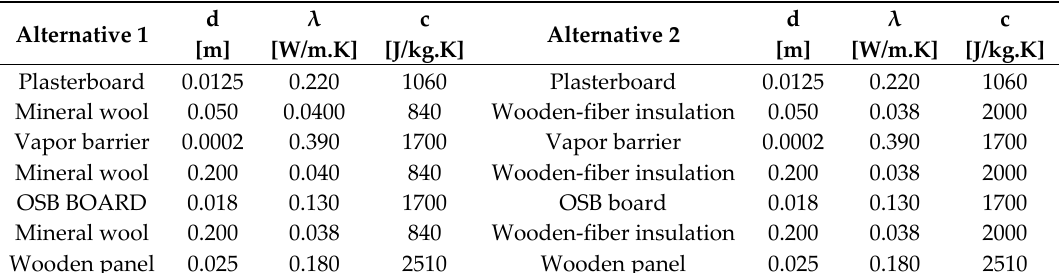
Table 2. Waals, Alternative 1—R = 10.42 m 2 ·K/W, U = 0.09 W/m 2 ·K, Alternative 2—R = 10.52 m 2 ·K/W, U = 0.09 W/m 2 ·K.